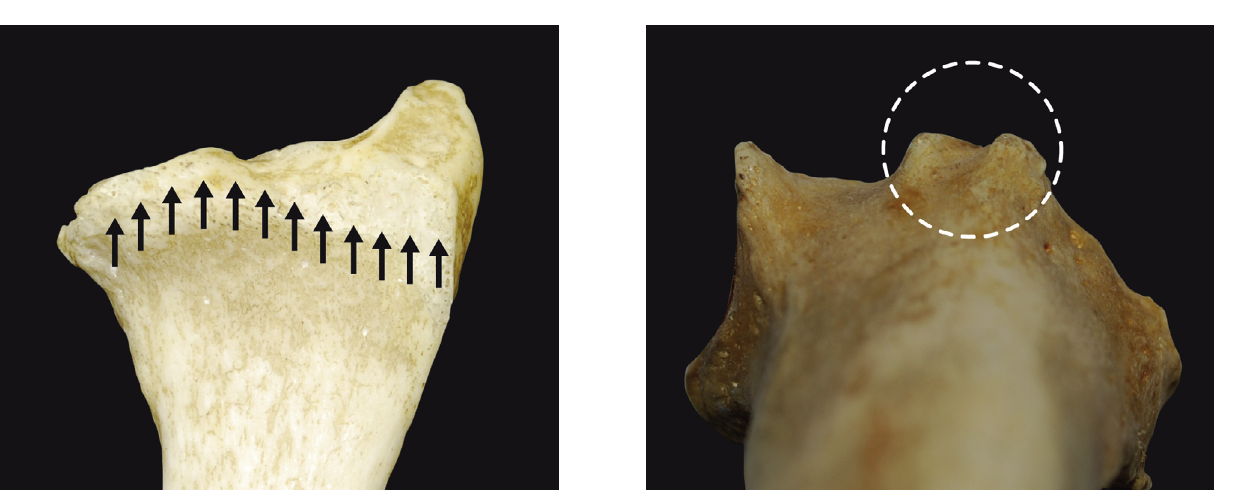
Figure 4. The area where a plate is applied is more ulnar than radial. Plate design should be based on this principle, and should not be too radial because the ulnar column is further forward than the radial column.